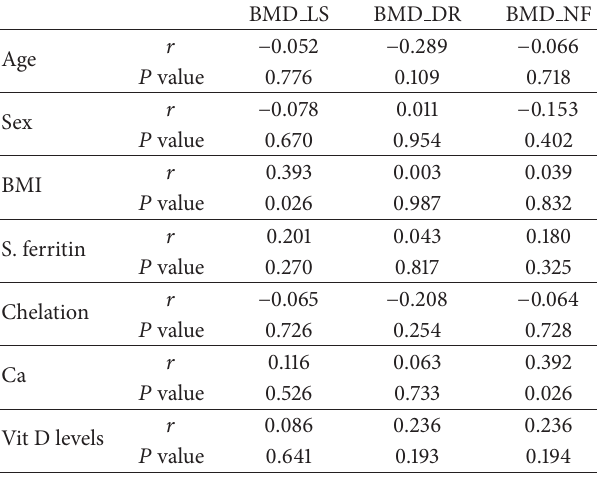
Table 2: Correlation of bone mineral density at lumbar spine (LS), distal radius (DR), and neck of femur (NF) in